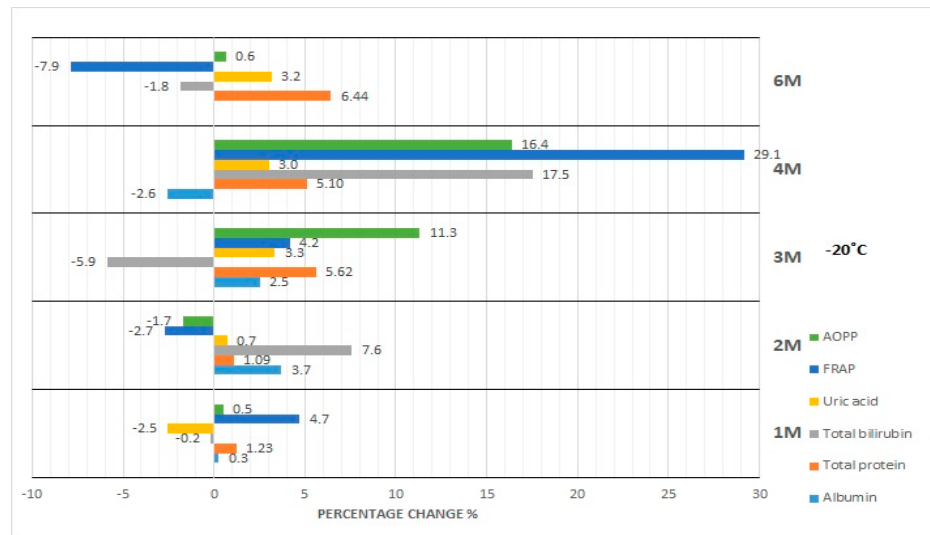
Figure 1. Percentage changes in concentration of selected parameters after storage of serum samples for 24–120 h at room temperature (RT) and 4 °C (fridge temperature, FT), AOPP—advanced oxidation protein products, FRAP—ferric reducing ability of plasma, UA—uric acid, Bil—bilirubin, TP—total protein, Alb—albumin.